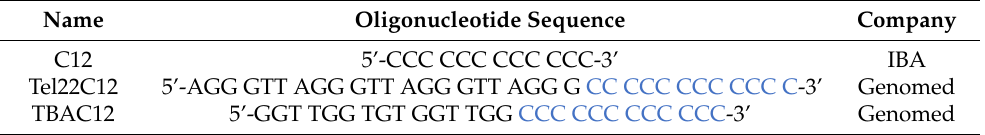
Table 1. The DNA oligonucleotide sequences used in this